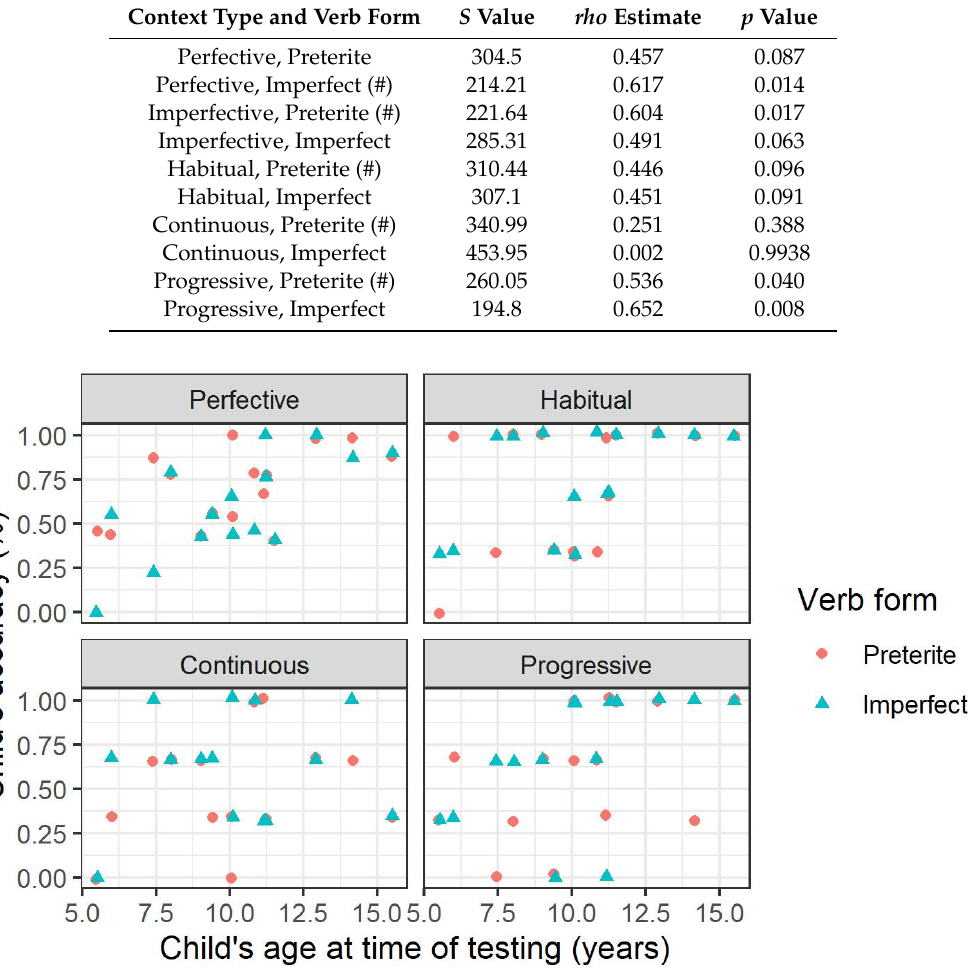
Figure 5. Children’s age in years at time of testing and their accuracy for each morpheme in four contexts (perfective, habitual, continuous and